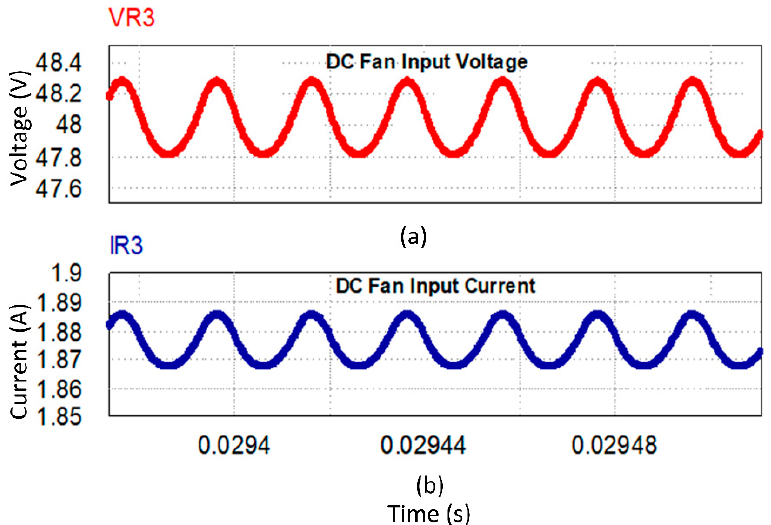
Figure 9. DC Fan Load Input Voltage and Current Waveform. DC Fan Input Voltage Ripple: 2.37%; Current Ripple: 0.337%. (a)DC fan input voltage; (b) DC fan input current.